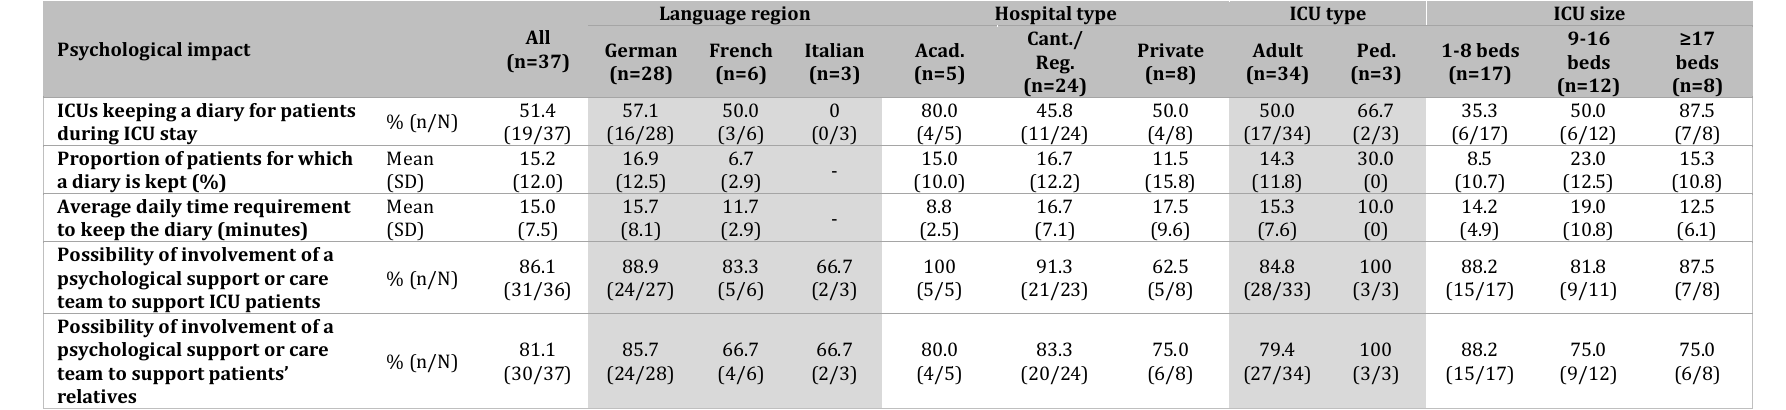
Table S18. Psychological impact (including both adult and pediatric ICUs)